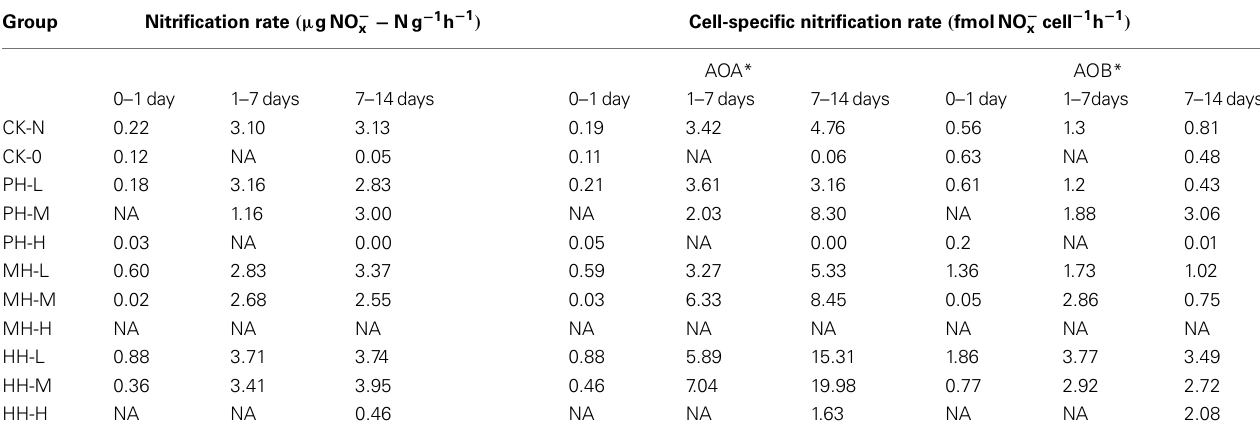
TableA1 | Estimated cell-specific nitrification rates ofAOA andAOB in